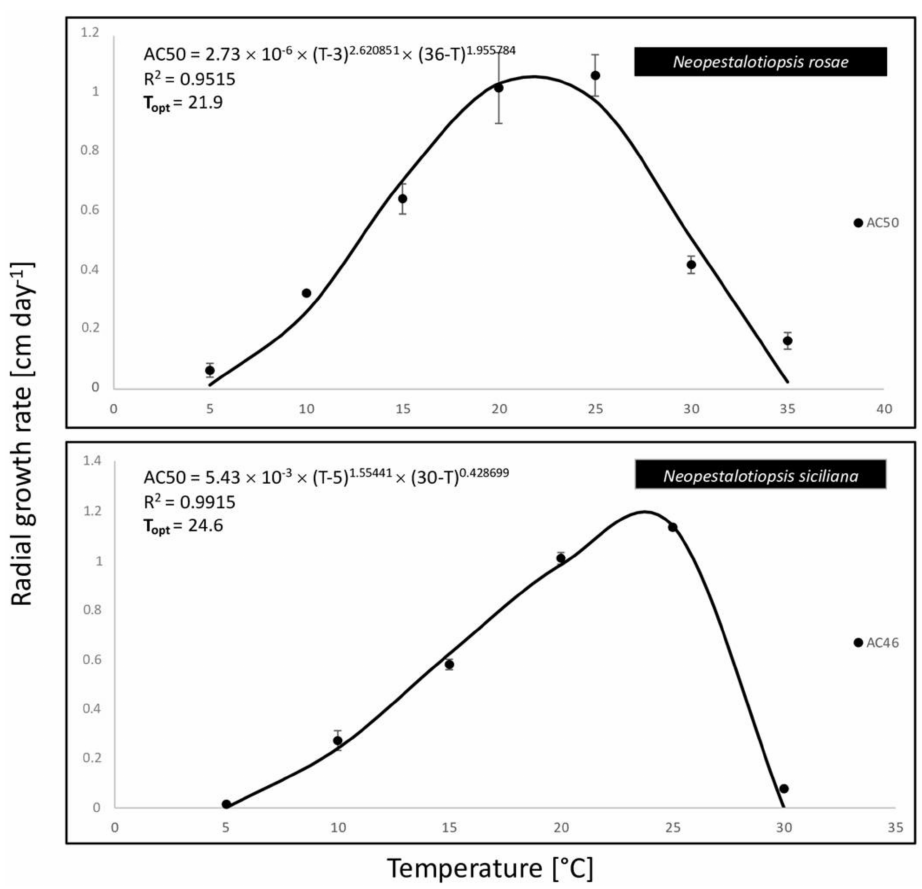
Figure 3. Effect of temperature on mycelial growth rate of two Neopestalotiopsis spp. isolated from avocado. The averages of radial growth rate and temperatures were adjusted to a nonlinear regression curve through the Analytis β model. Data points are the means of two independent experiments of three replicated Petri dishes. Vertical bars are the standard error of the